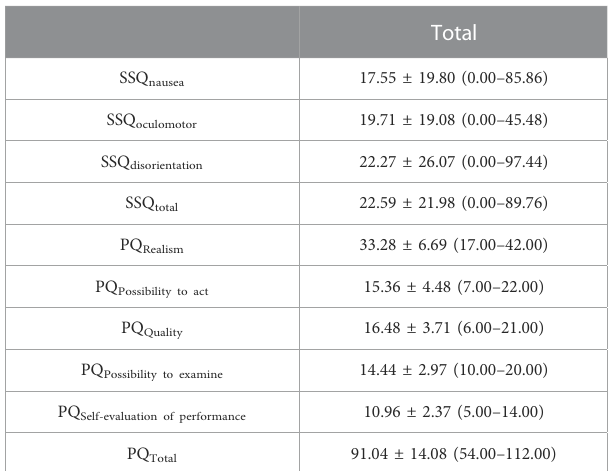
TABLE 1 Simulator Sickness Questionnaire and Presence Questionnaire results post simulation including subscales. Data are presented as mean ± standard deviation with range in brackets.